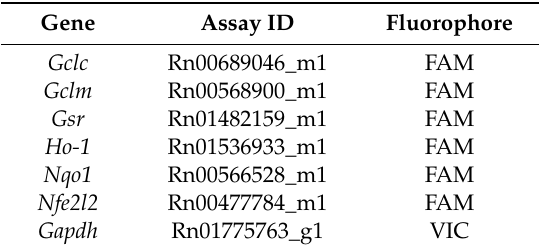
Table 1. List of Taqman gene